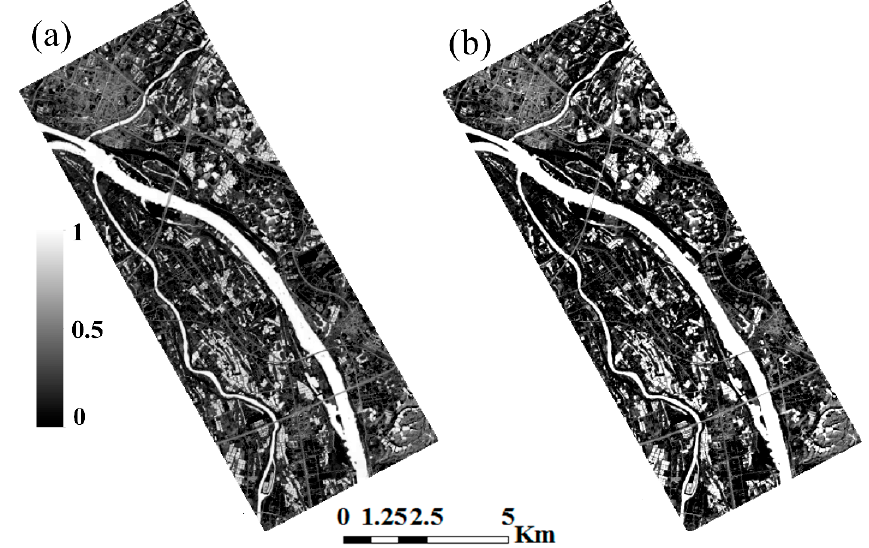
Figure 11. Surface water fractions of Region D extracted by the: ( a ) conventional; and ( b ) modified linear spectral mixture analysis (LSMA) methods.